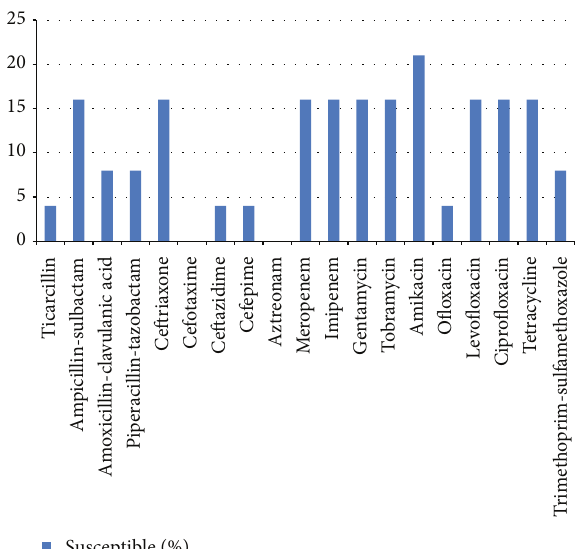
Figure 1: Susceptibility pattern of A. baumannii isolates ( 𝑛 = 24 ) to various